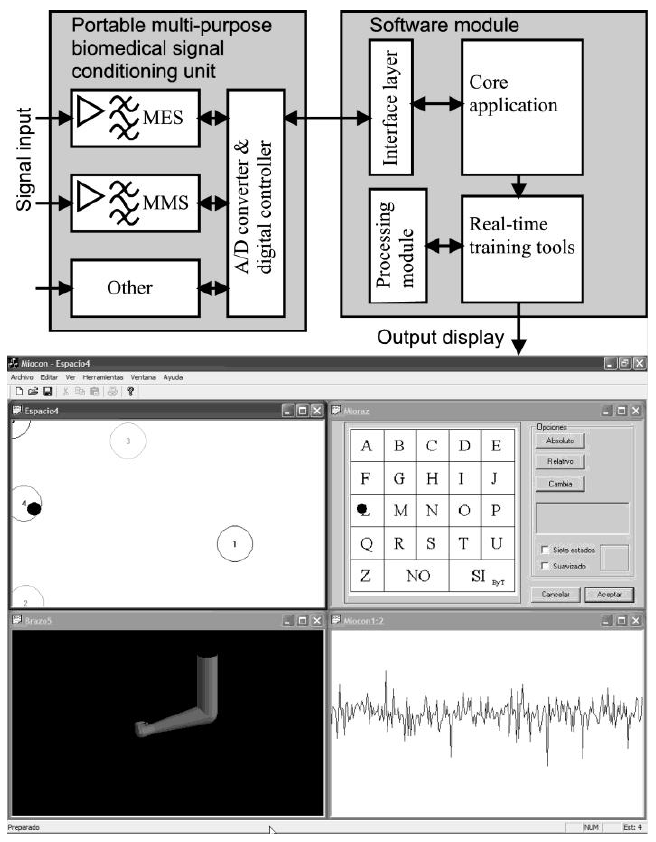
Figure 1. Block diagram of the UVa-NTS which is composed of a hardware signal-conditioning unit, a software module running on a PC and a graphical user interface (GUI). Tools displayed on the GUI: State navigator (top left), virtual keyboard (top right), virtual arm (bottom left), signal viewer (bottom right).